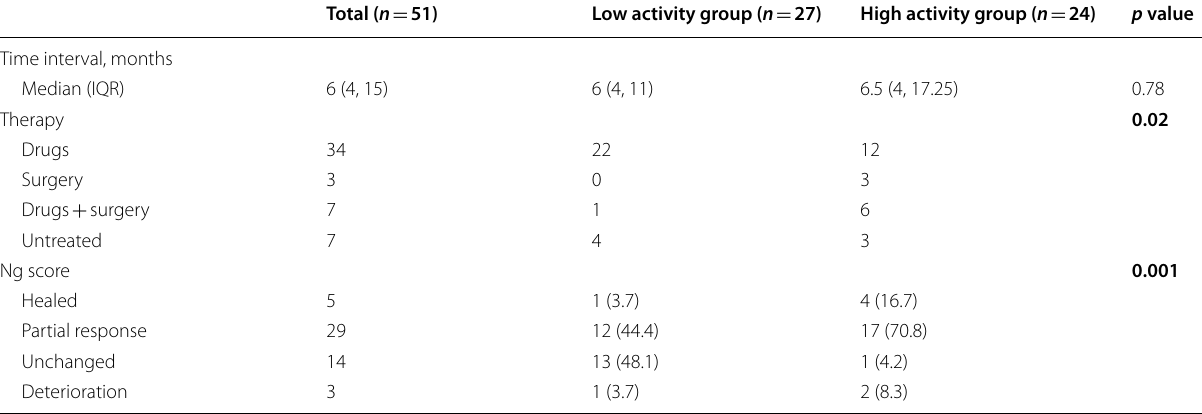
Table 4 Follow-up information of fifty-one patients